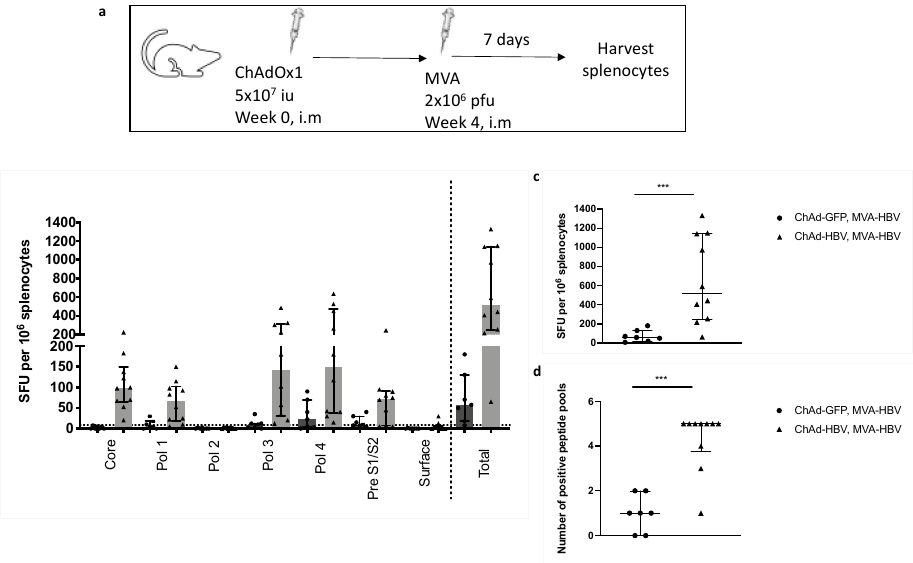
Figure 7. ChAd-MVA prime-boost vaccination in HHD mice induces T-cell response to HBV-core peptides. HHD mice were vaccinated intramuscularly (i.m) with 5 × 10 7 iu (infectious units) of ChAdOx1-SP-SIi-CP mut TPA-S (sh) or ChAdOx1-GFP as a negative control, followed 4 weeks later by 2